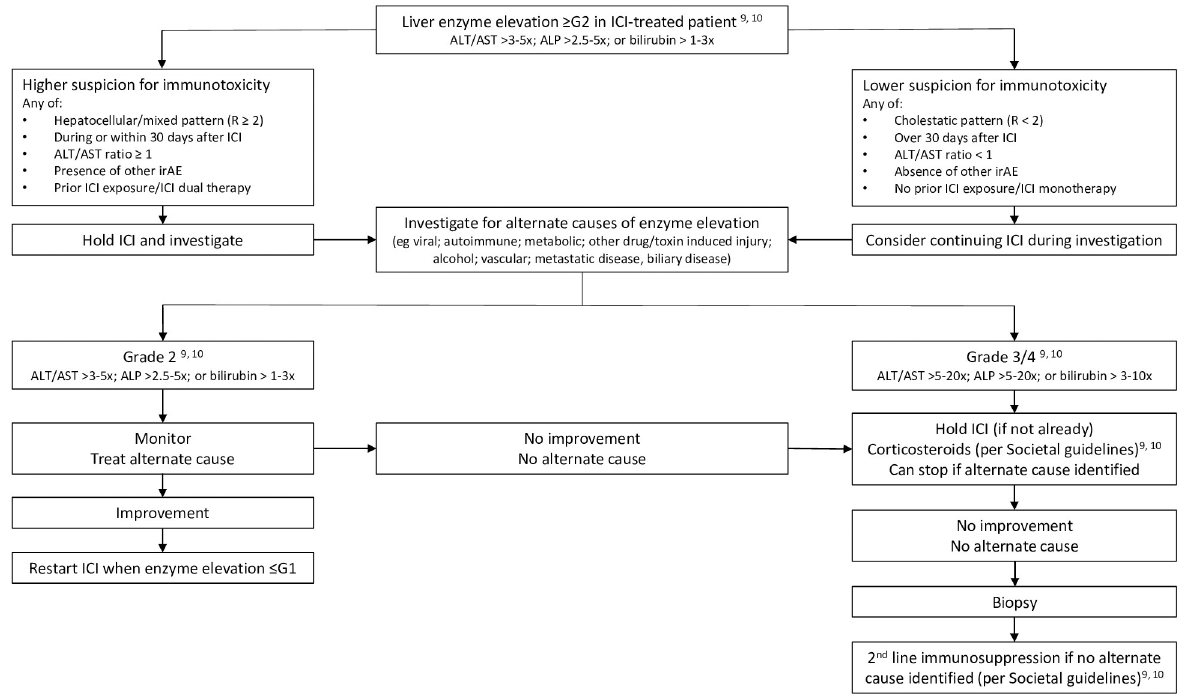
Fig 4. Proposed algorithm to guide diagnostic evaluation of immune checkpoint inhibitor (ICI)-treated patients with liver enzyme elevation. Stratification of ALT, AST, ALP and bilirubin elevation is as per CTCAE (v. 5.0; S1 Table) [6]. Definitions of Grade 2, 3 and 4 enzyme elevation as they relate to management of ICI-associated hepatotoxicity are as per European Society for Medical Oncology and American Society of Clinical Oncology Practice Guidelines [9, 10]. ALT, alanine transaminase, AST, aspartate aminotransferase; ALP, alkaline phosphatase.